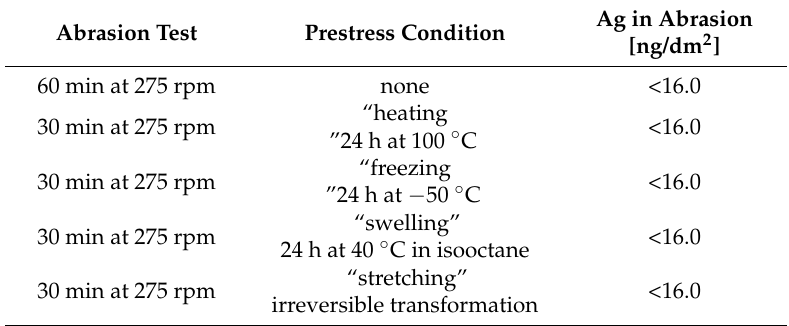
Table 2. Results of the abrasion test performed with silver